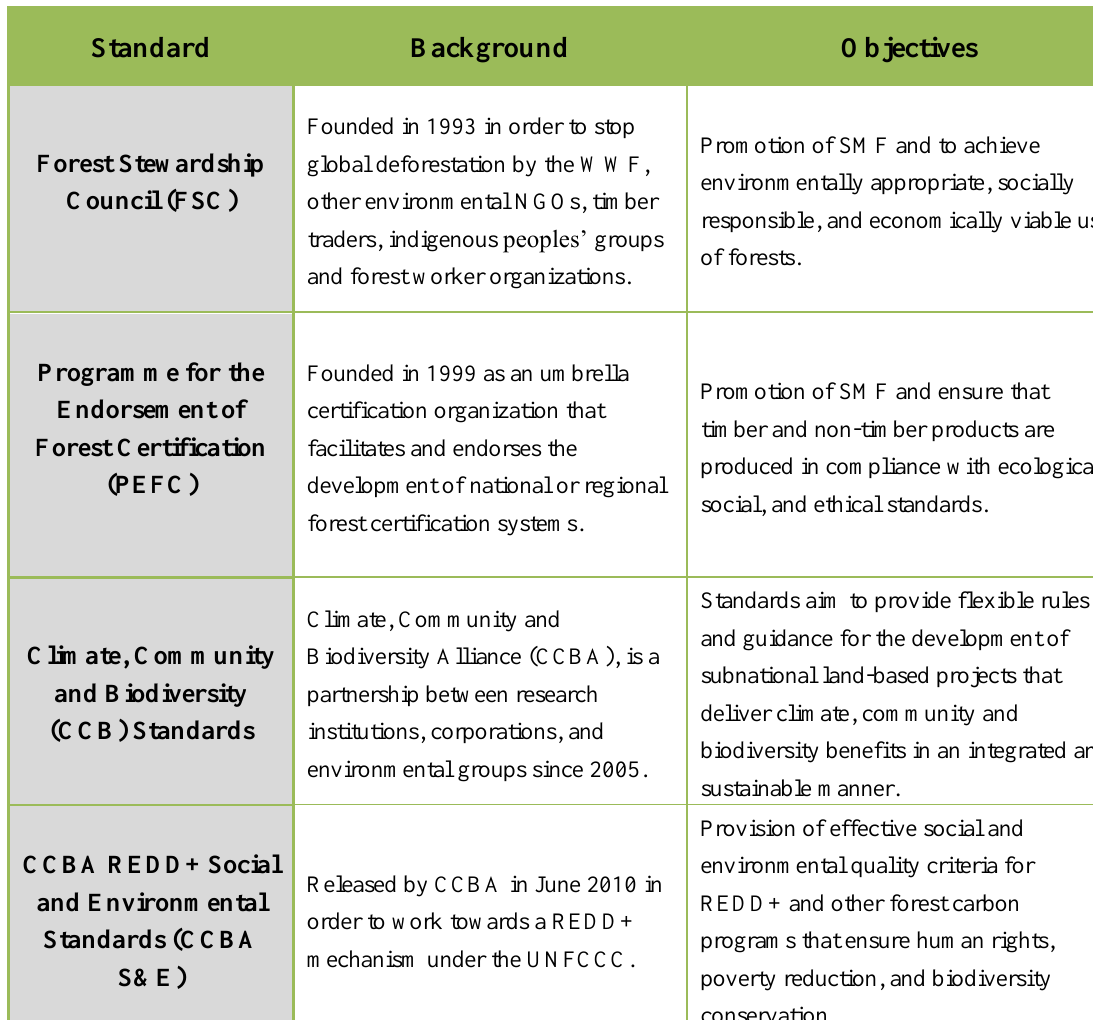
Table 1. Summary of standards’ background and